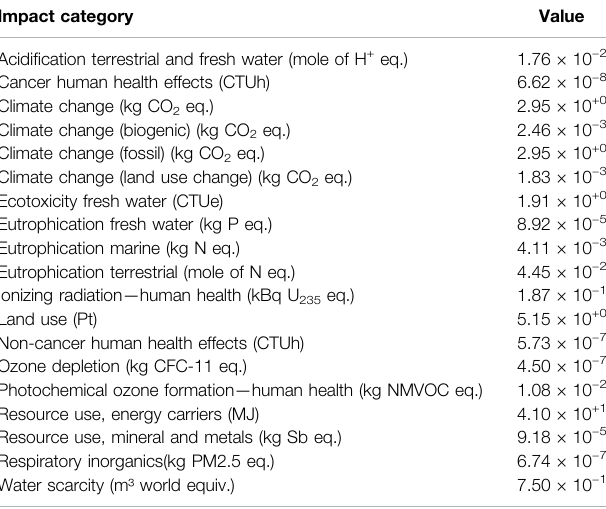
TABLE 2 | Impact assessment per functional kWh.